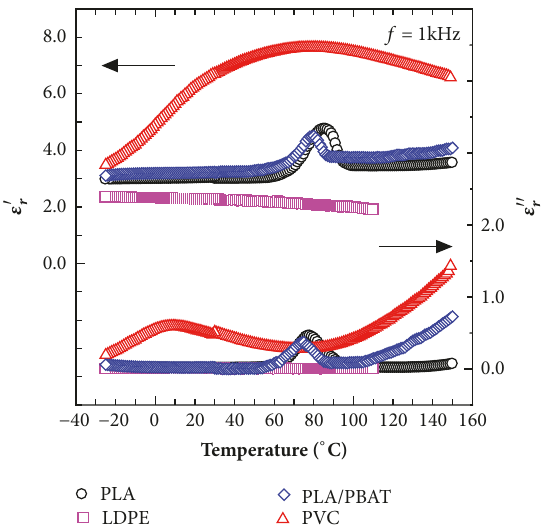
Figure 9: Values of 𝜀 󸀠 𝑟 and 𝜀 󸀠󸀠 𝑟 of PLA and PLA/PBAT.